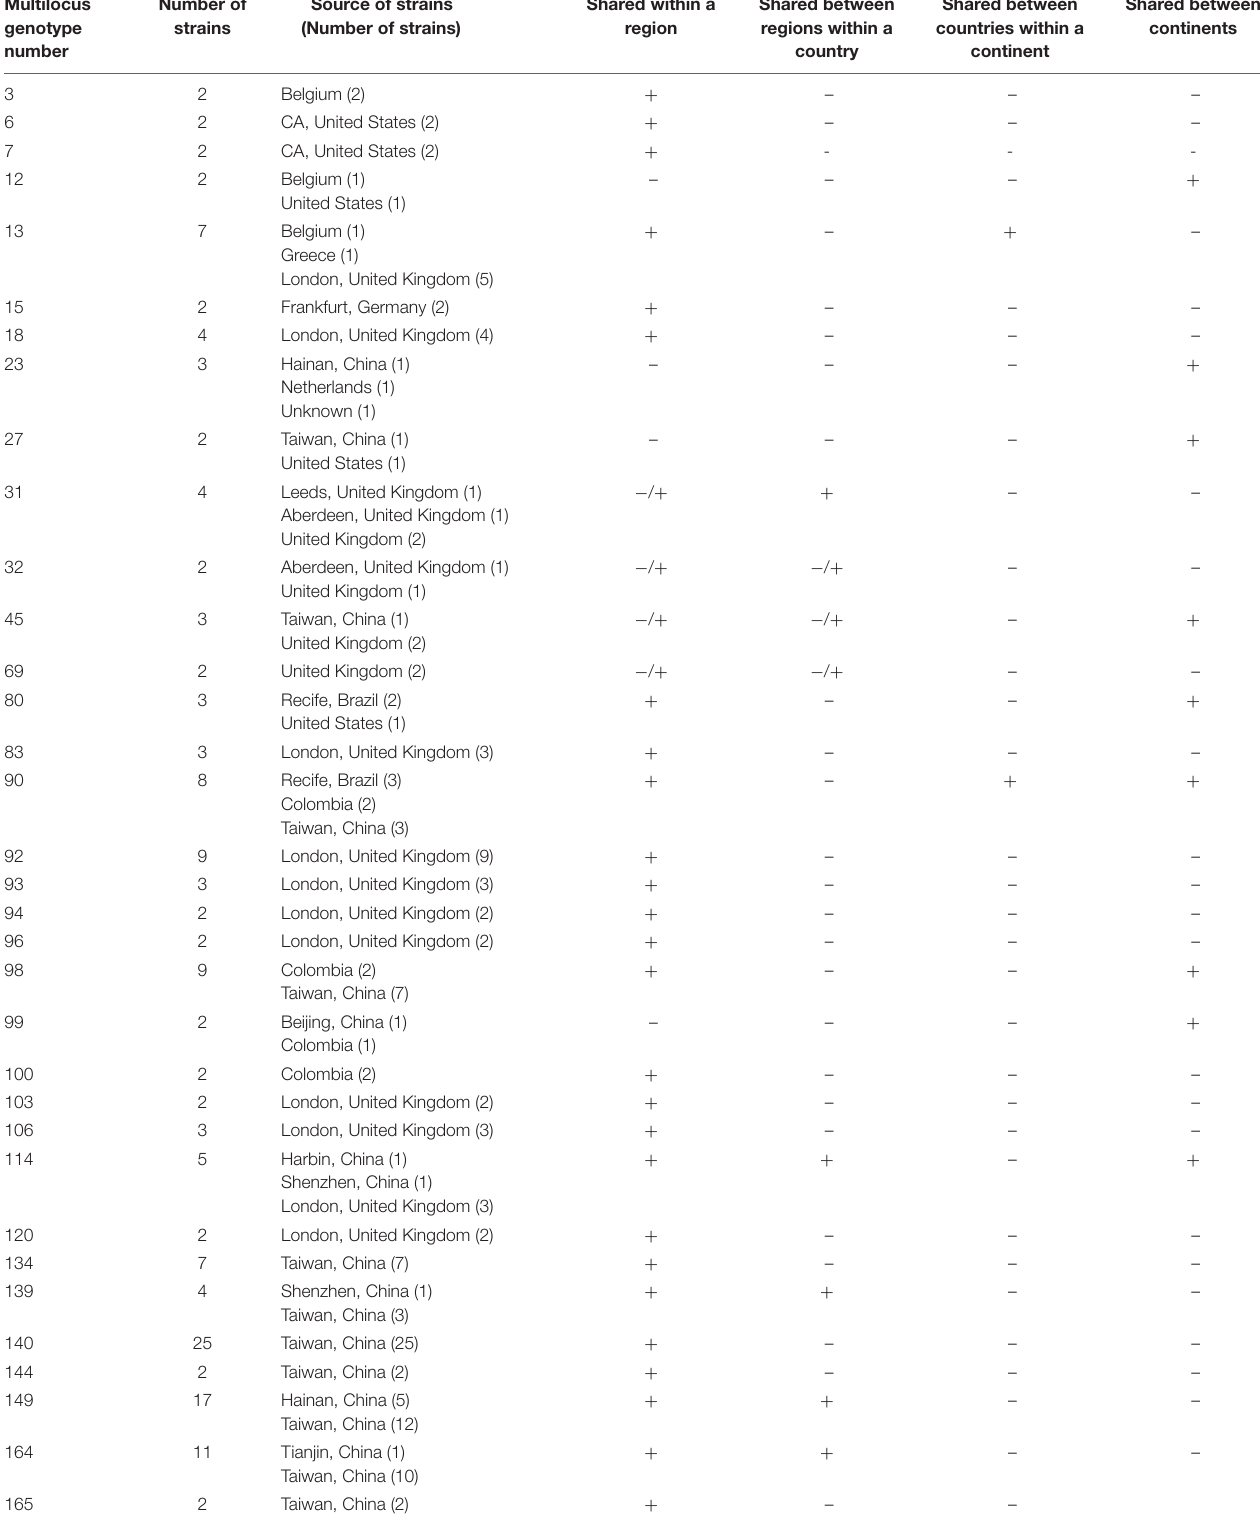
TABLE 3 | Shared multilocus genotypes of Candida tropicalis in the MLST